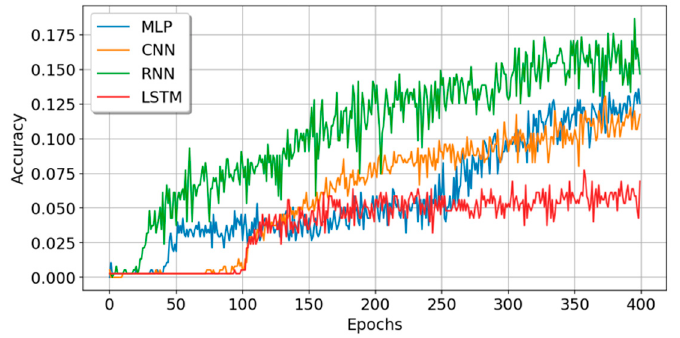
Figure 12. Loss values during training of four